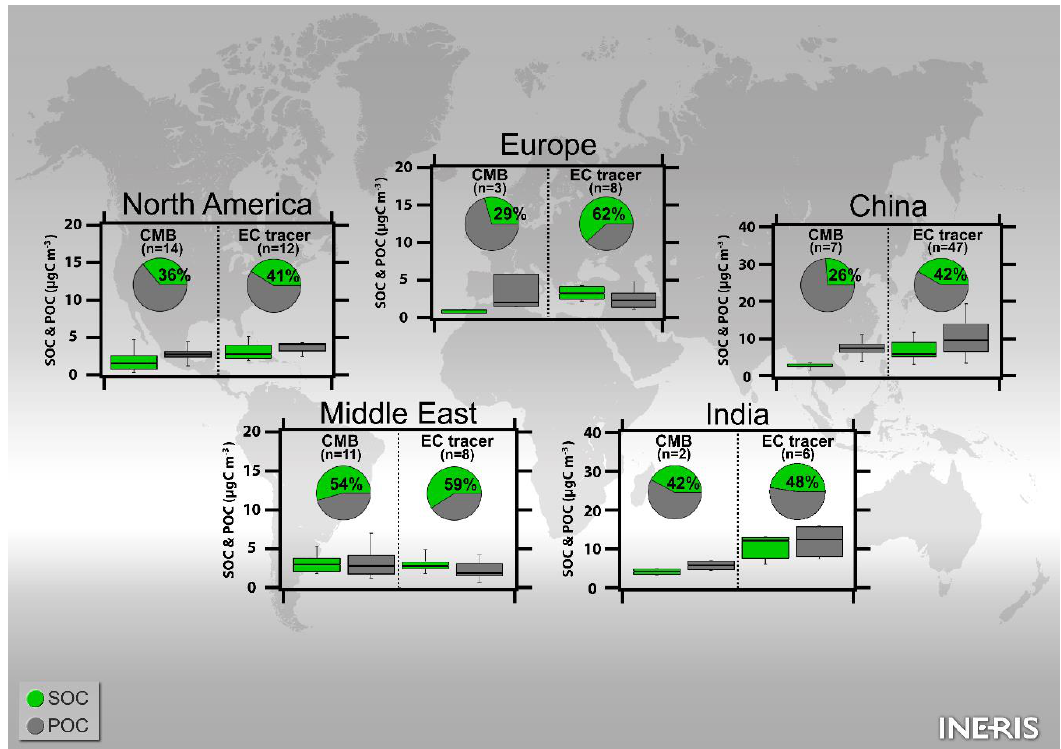
Figure 9. Comparison of annual SOC estimates (PM 2.5 ) obtained using CMB and EC tracer method for North America, Europe, the Middle East, India and China. Only urban and suburban locations are included. Box-plots show the SOC and POC concentrations (µgC m −3 ) for each continent and each method. Into brackets, number of data points considered. Box plots include minimum (10th), first quartile (25th), median (50th), third quartile (75th) and maximum values (90th).